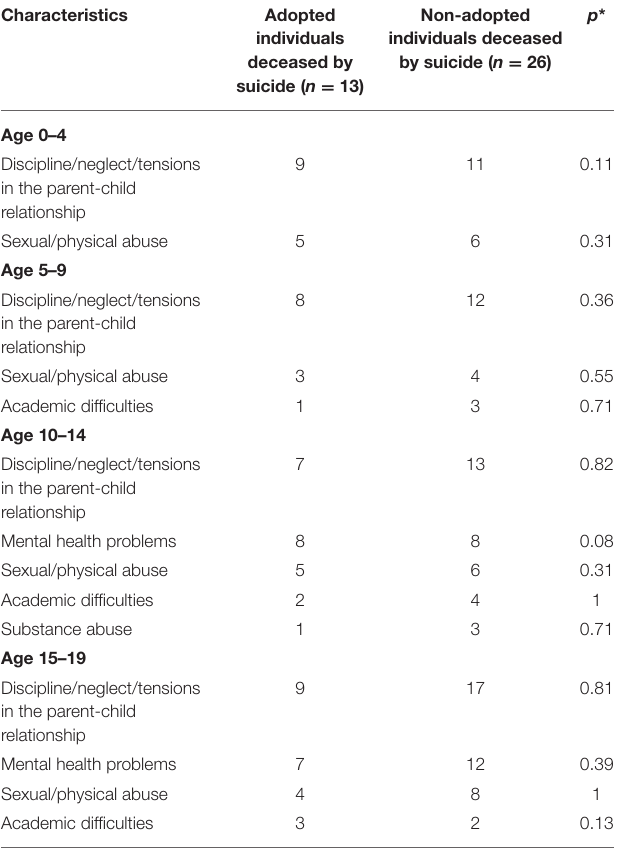
TABLE 2 | Childhood life-events comparison between adopted and non-adopted individuals deceased by suicide ( n = 39). Characteristics